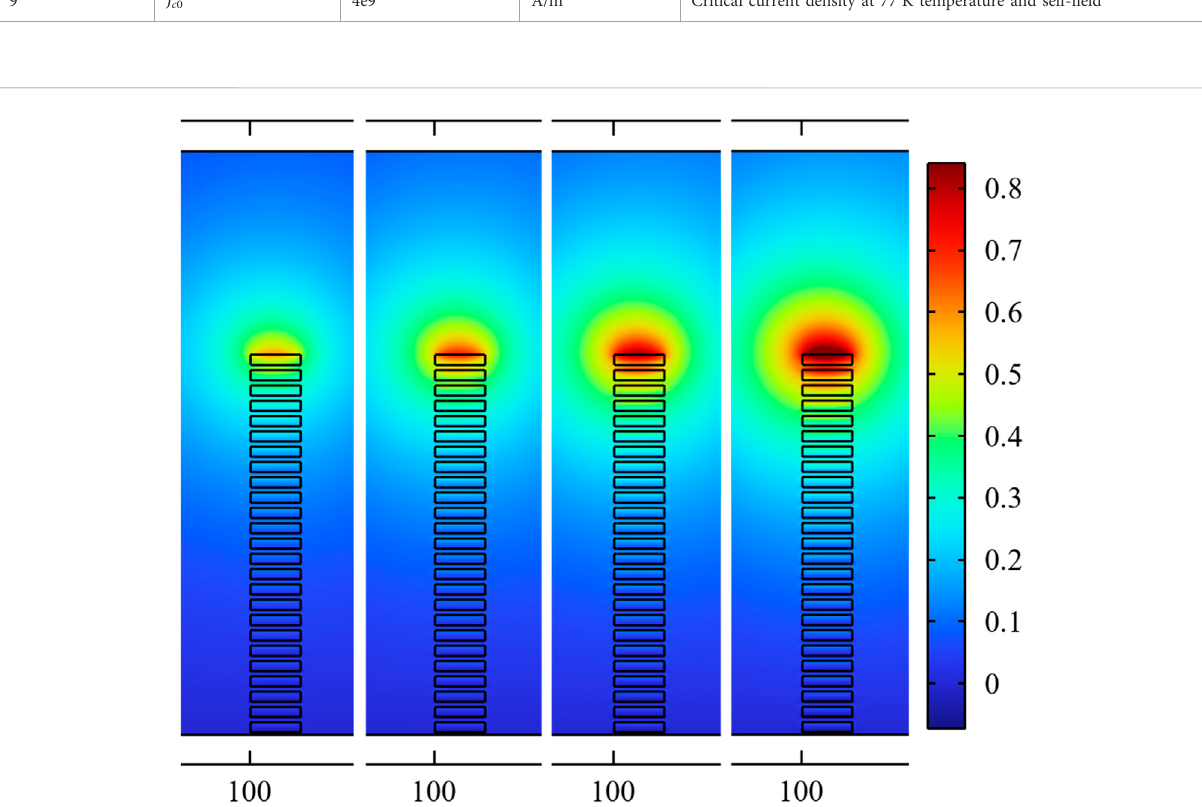
FIGURE 4 The magnetic fl ux density distribution in the r direction when the current carried by the superconducting solenoid is 100, 120, 140 and 160 A.